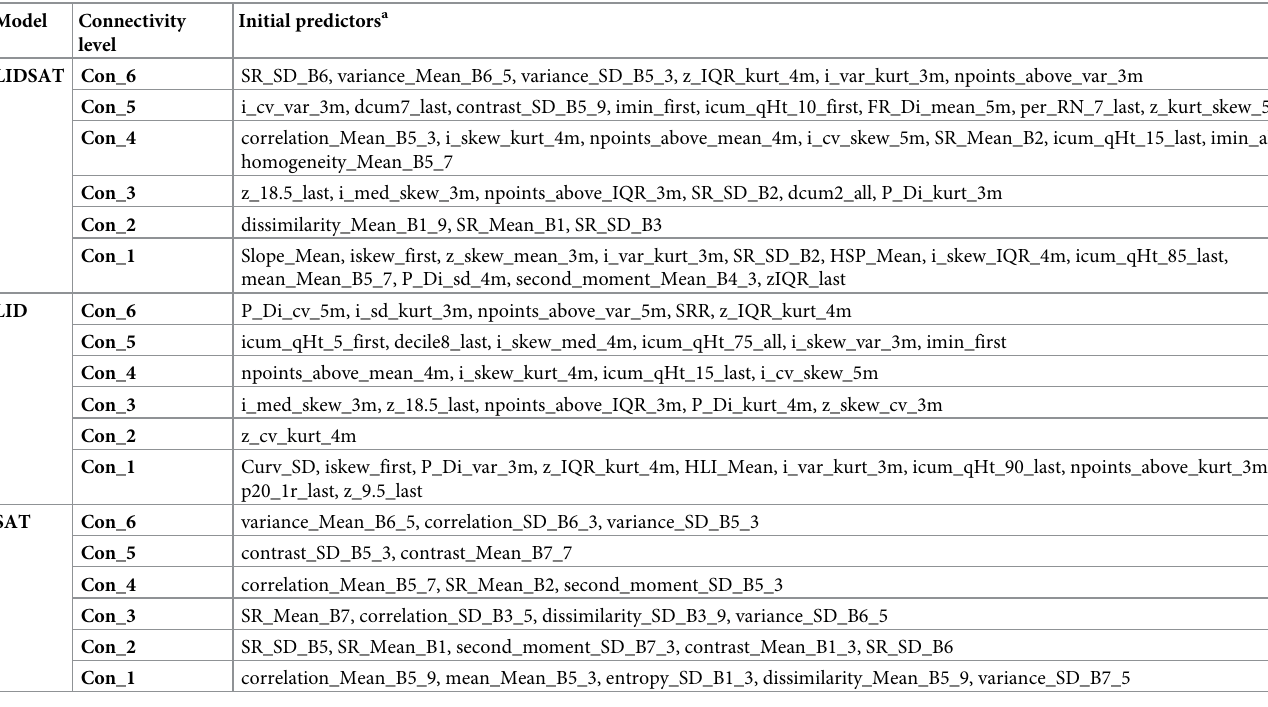
a Predictor variable names correspond to the lidar-derived metrics listed in Table 1 and to the satellite-derived metrics listed in Table